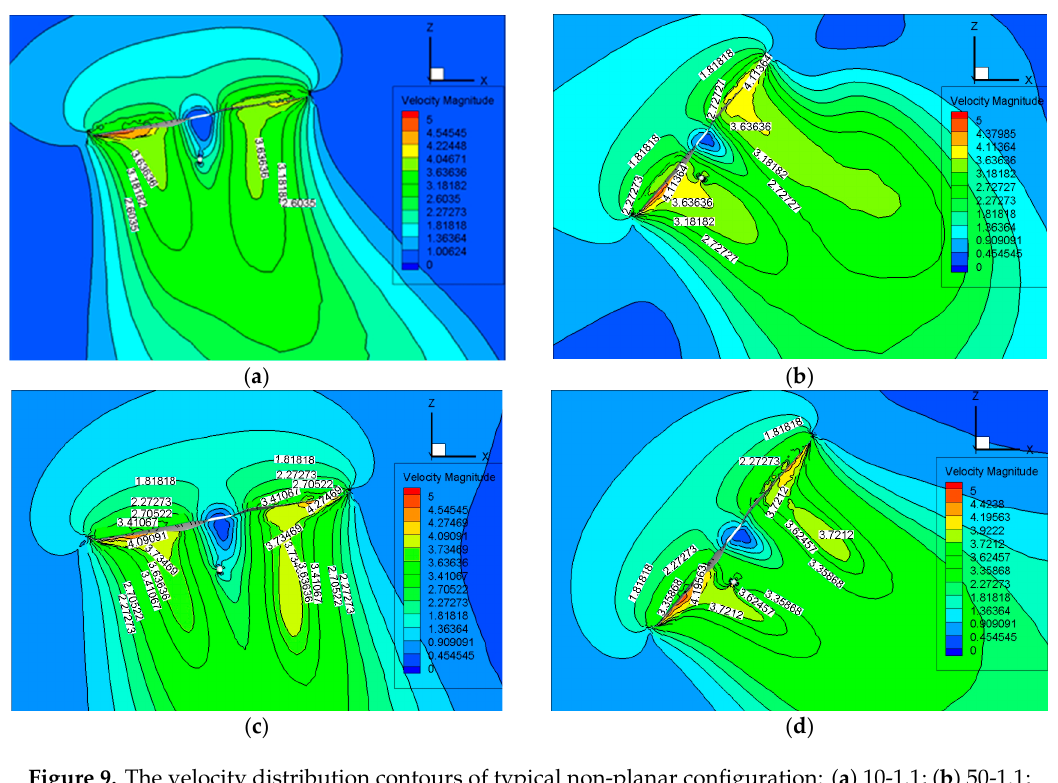
Figure 9. The velocity distribution contours of typical non-planar configuration: ( a ) 10-1.1; ( b ) 50-1.1; ( c ) 10-2; ( d ) 50-2.